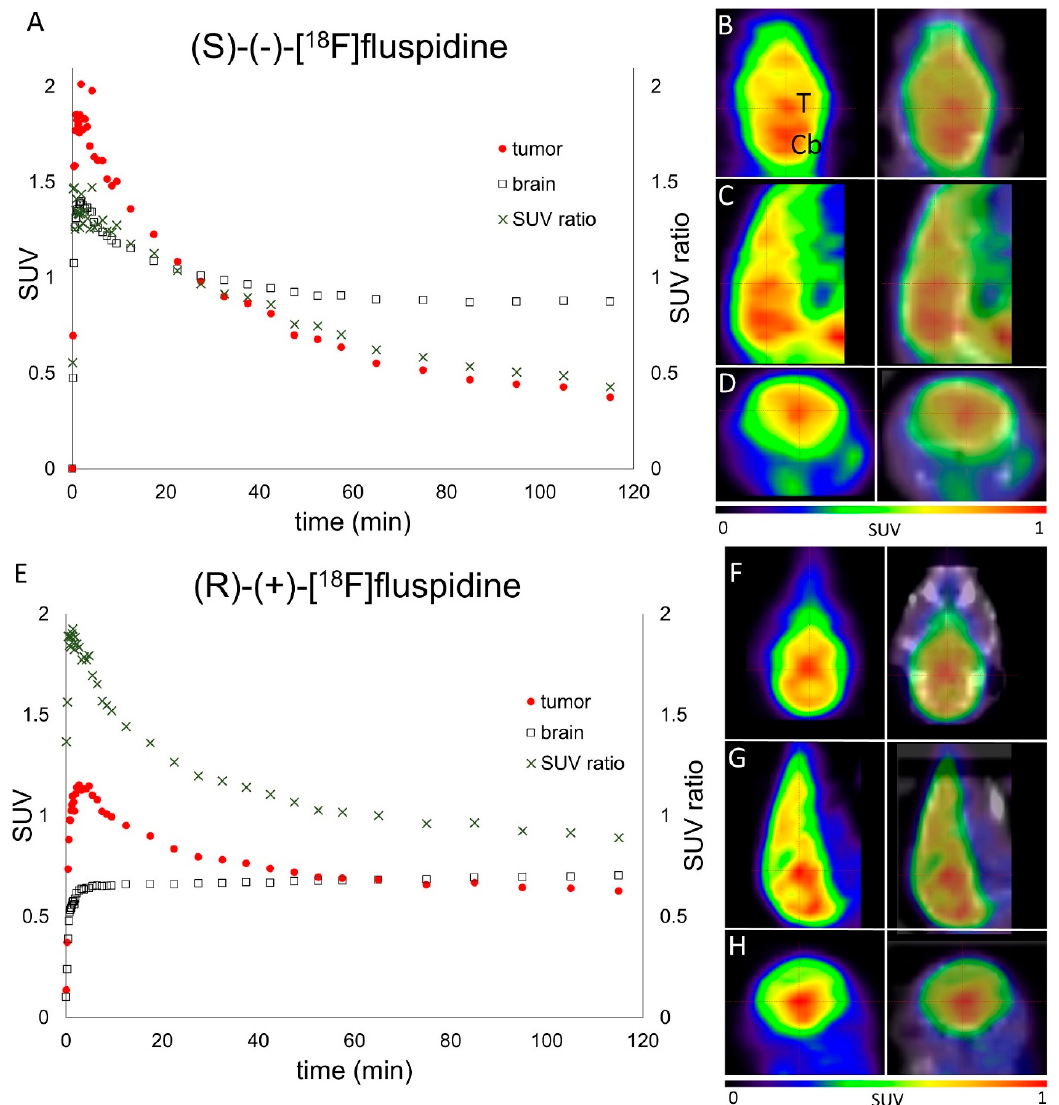
Figure 4. In vivo PET/CT imaging of mice with orthotopically implanted glioblastoma cells (U87-MG) after i.v. administration of ( S )-( − )-[ 18 F]fluspidine ( n = 2) ( A – D ) or ( R )-(+)-[ 18 F]fluspidine ( n = 3) ( E – H ).